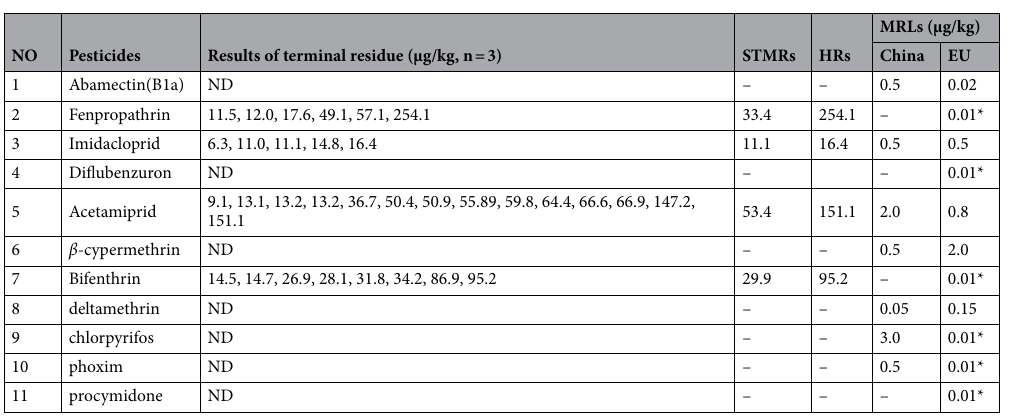
Table 3. The terminal residues of 11 pesticides in apricot samples collected from different ecological planting regions in China. “STMR” is the supervised trials median residue. “HR” is the highest residue. “-” is not detected. “–” is the limit standard has not been established. “*” is the temporary maximum residue limits.